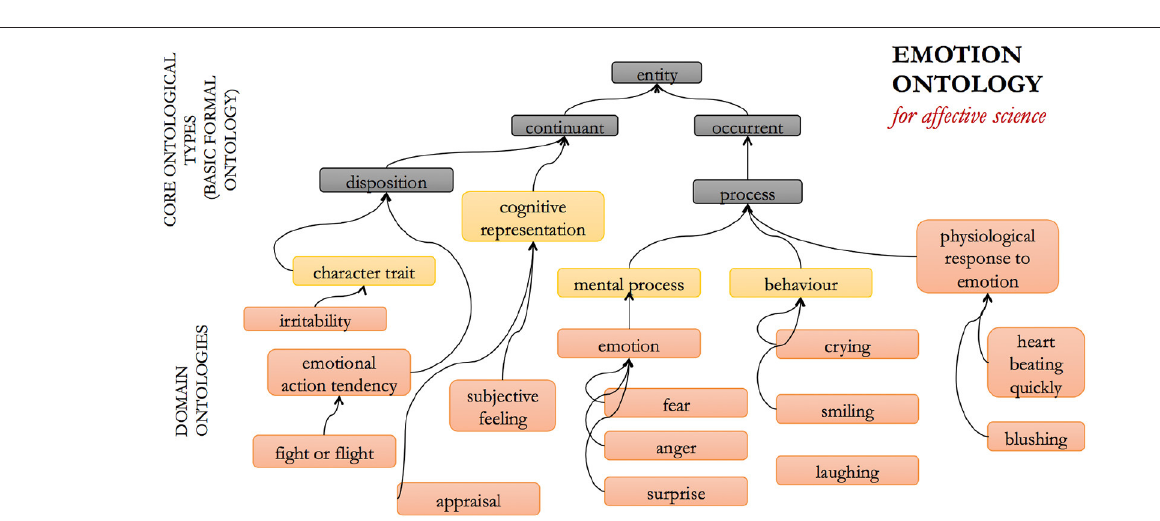
FIGURE 3 | The emotion ontology (EM): selected entities and